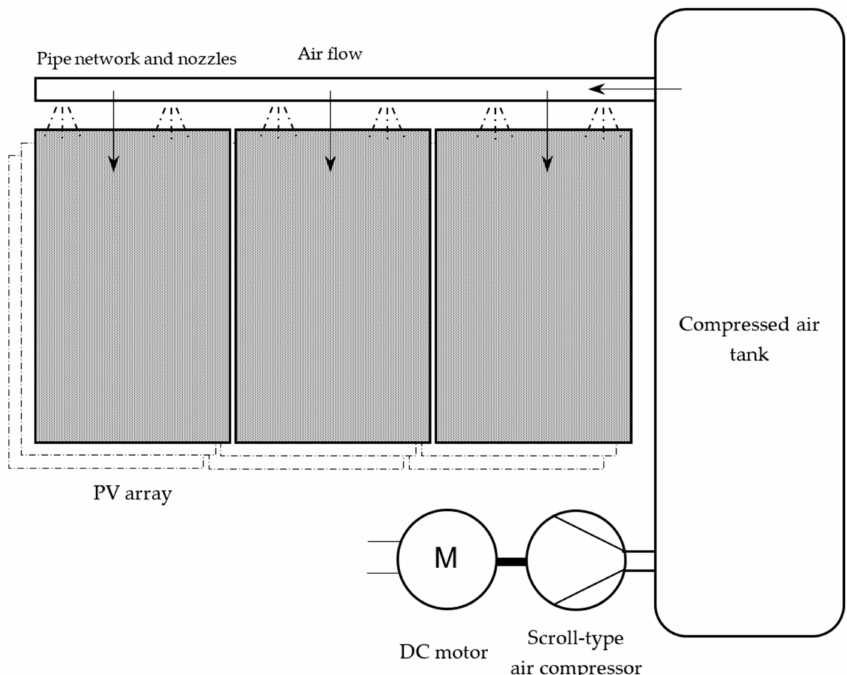
Figure 1. The proposed system is comprised of a DC motor which charges a scroll-type air compressor. Air accumulates in a storage tank and then can be discharged to blow air over the surface of PV panels. This action will clean and cool the